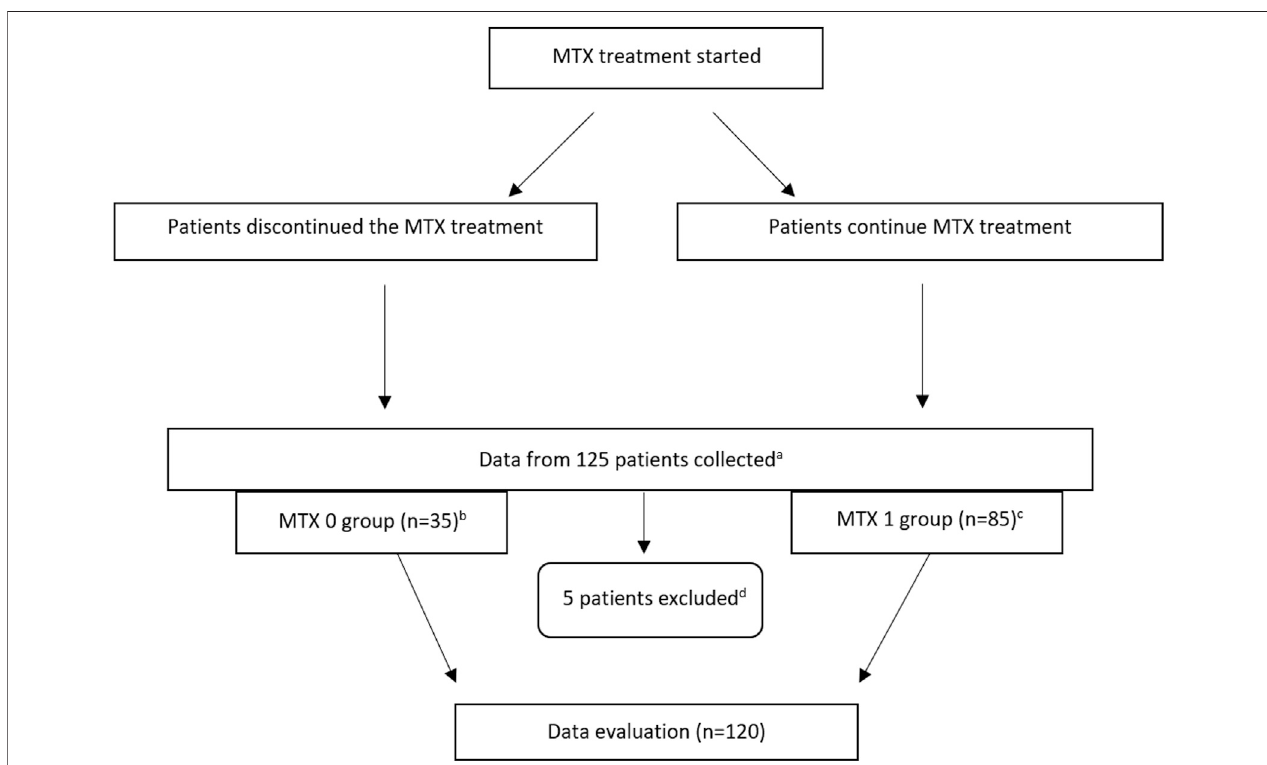
FIGURE 1 | Flow diagram. (A) Patients from previous study (Soukup et al., 2015) who visited rheumatologic outpatient clinics at the University Hospital of Hradec Králové with the diagnosis of RA during the data collection and who were treated with MTX at the time of data collection or anytime in the past, and all deceased participants from the abovementioned study. (B) Average time from MTX discontinuation in the MTX 0 group was 7.54 (SD ± 4.21) years. (C) In the MTX 1 group, the patientshadbeentreatedwithMTXforanaverageof10.9 years(SD ± 5.0). (D) Twopatientsrefusedtobeenrolledinthestudy,onepatientcouldnotbeexamined due to hospitalization for active oncologic disease at the time of data collection when medical records from two deceased patients were not available. n, number; MTX, methotrexate; MTX 1, patients treated with MTX at the time of data collection; MTX 0, patients without MTX treatment at the time of data collection.